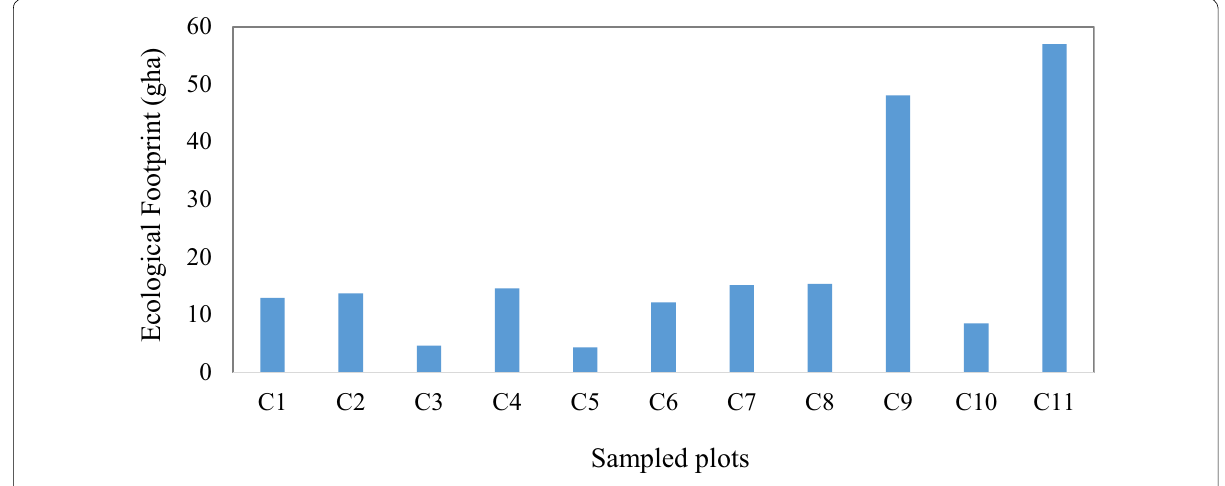
Fig. 3 Ecological footprint of residences on the sampled